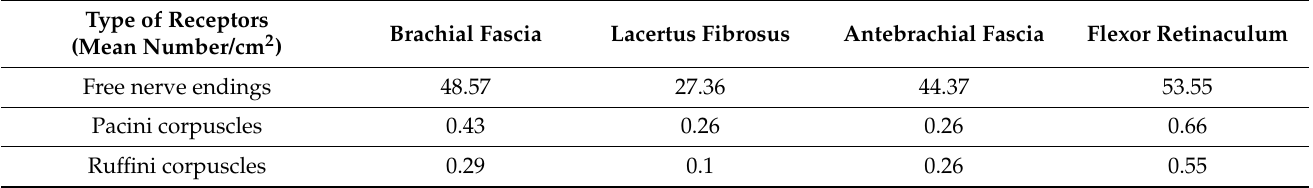
Table 2. Summary of the mean number of receptors per cm 2 observed in the different areas of the superior